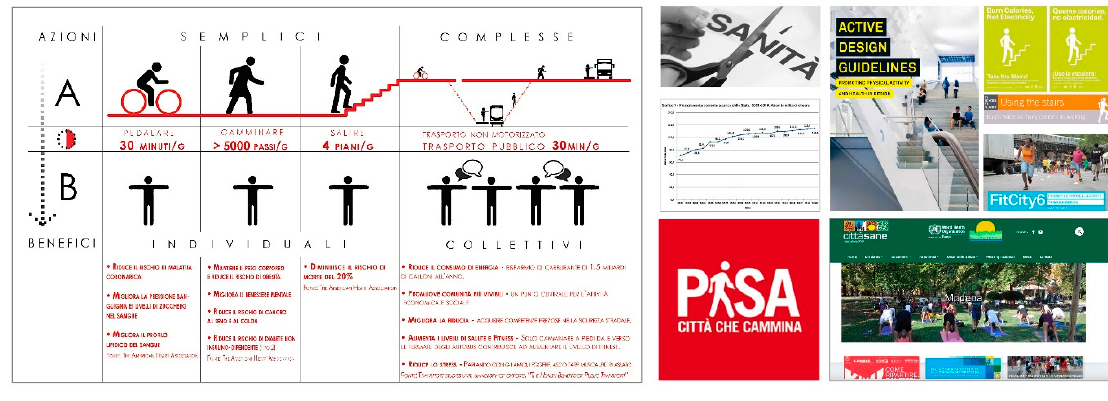
Figure 1. Left: Health benefits of an active life for the individual and the community; right: Italy’s Health Public expenditure 2009–19 and actions identified by public administrations (Source: Cities of New York, Pisa, Italian Network Healthy Cities)